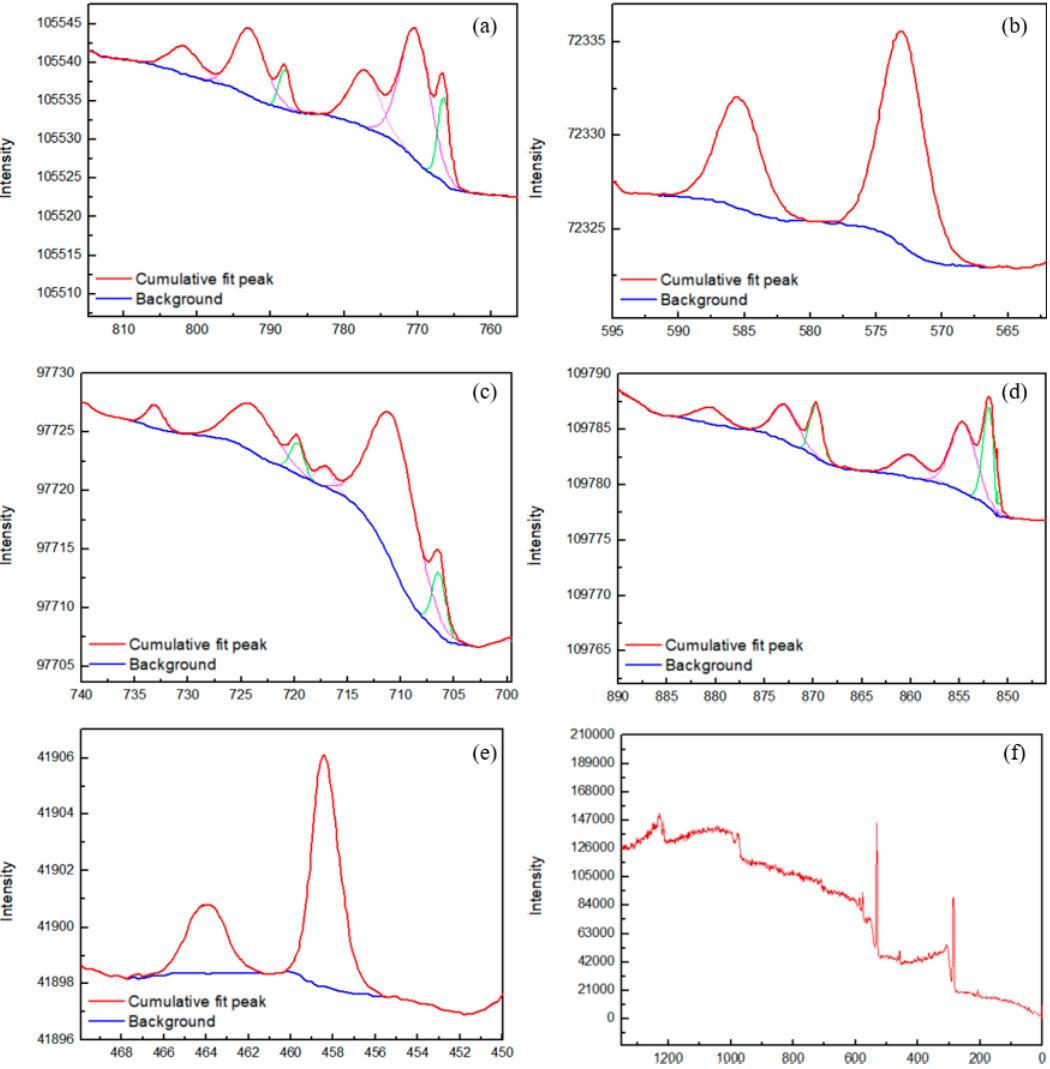
Figure 9. XPS spectra of the passivation film on CoCrFeNiTi x HEA coating. Peaks are attributed to ( a ) Co, ( b ) Cr, ( c ) Fe, ( d ) Ni, and ( e ) Ti species. ( f ) The entire XPS spectral